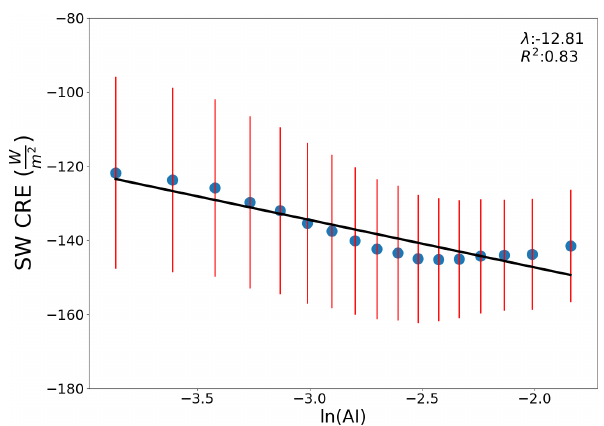
Figure 1. The sensitivity of CRE to aerosol ( λ 0 from Eq. 4) found globally from the mean SW CRE for each ln(AI) bin (blue dots) without constraints on the environment, cloud state, or region. The red lines represent the standard deviation within each bin of